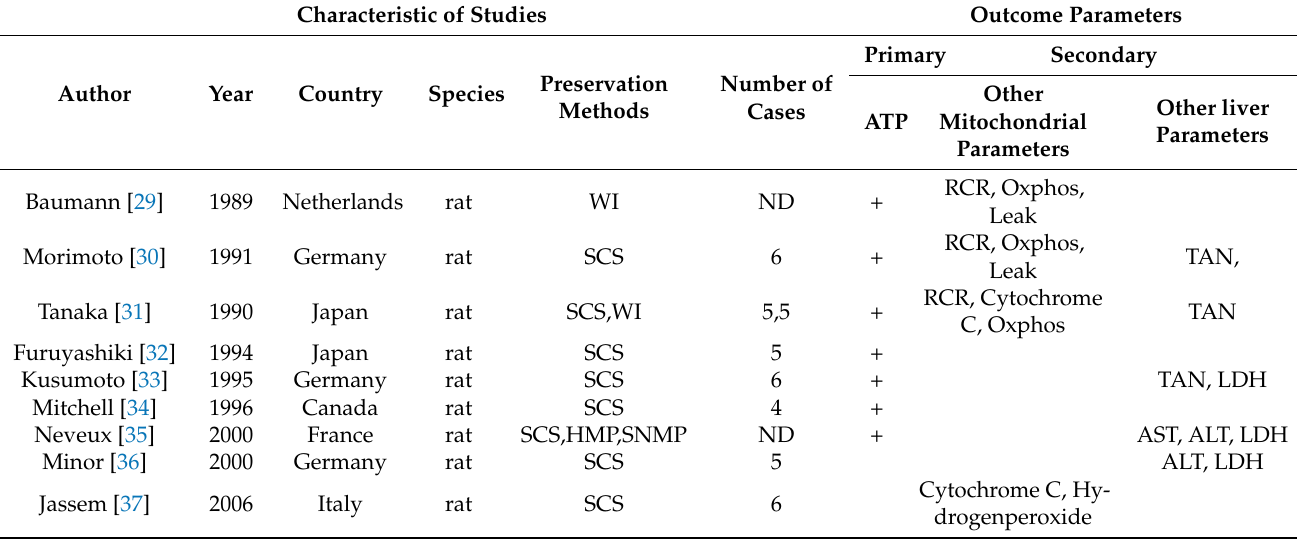
Table 2. Characteristics of included studies (RCR: respiratory control ratios; TAN: total adenine nucleotid; GDH: glutamate dehydrogenase; MDA: malondialdehyde; LDH: lactate dehydrogenase). Characteristic of Studies Outcome